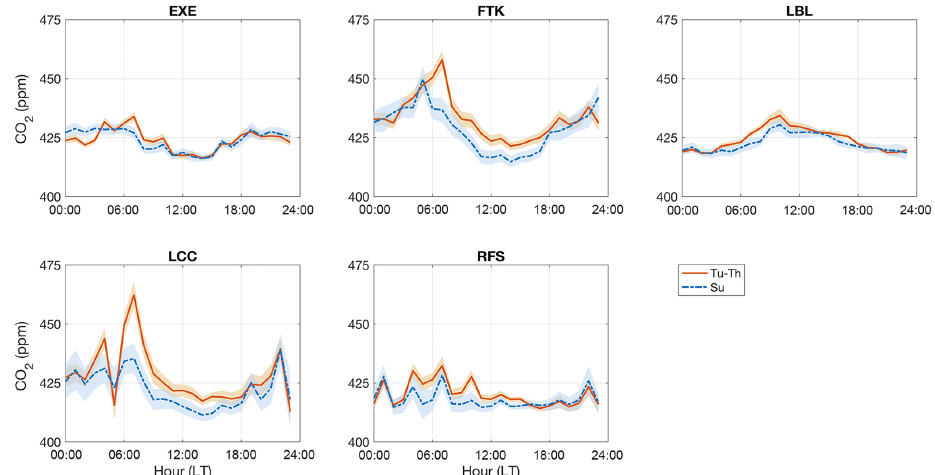
Figure 9. Hourly median CO 2 concentrations observed at five sites on Tuesdays through Thursdays (orange solid line) and Sundays (blue dashed line) between 15 February 2017 and 15 February 2018; lighter curves indicate the standard error in the